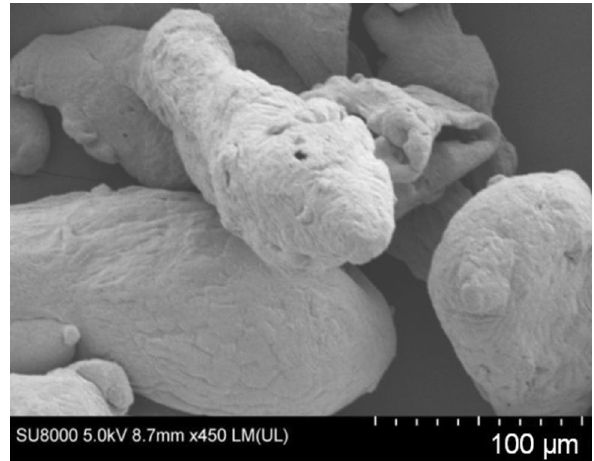
Fig. 1 SEM image of aluminum